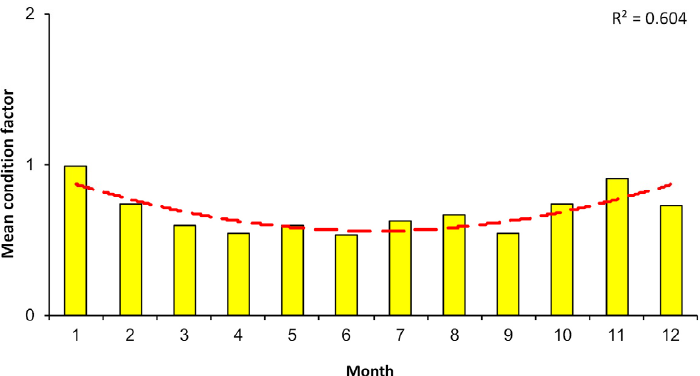
Figure 15. Changes in condition factor of the Aleutian skate Bathyraja aleutica from the North Pacific across the year; (yellow bar)—mean value, (dash line) smoothed trend (R 2 = 0.604).